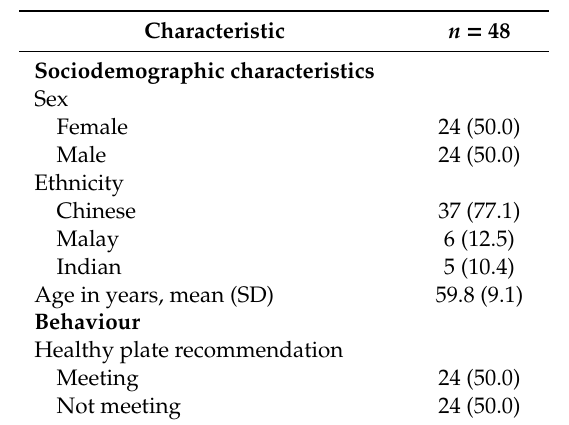
Table 3. Participant characteristics for the in-depth